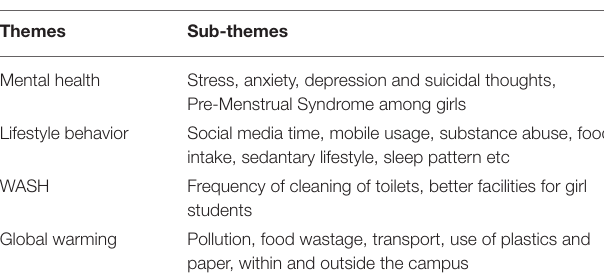
TABLE 2 | Themes and sub-themes of key student issues that emerged through free-listing and